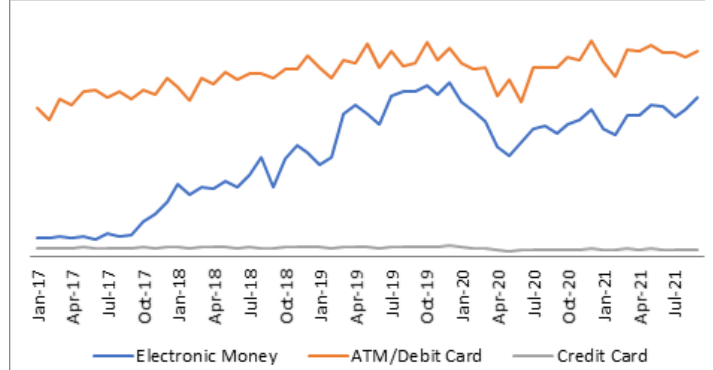
Figure 1: Non-cash Transaction Volumes in Indonesia, 2017-2021